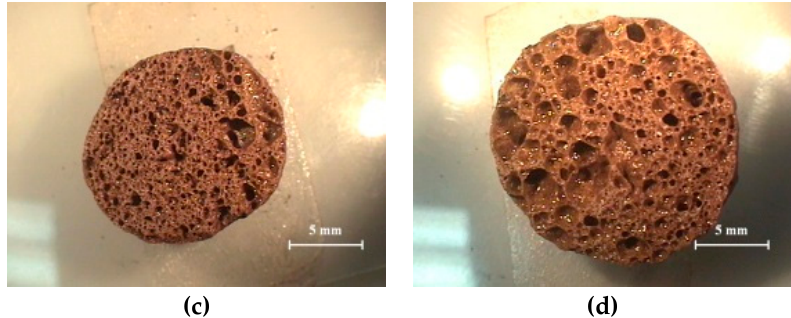
Figure 6. Cross section of the aggregate fired by the rapid sintering method: ( a ) 1100 °C; ( b ) 1150 °C; ( c ) 1175 °C; ( d ) 1200 °C.